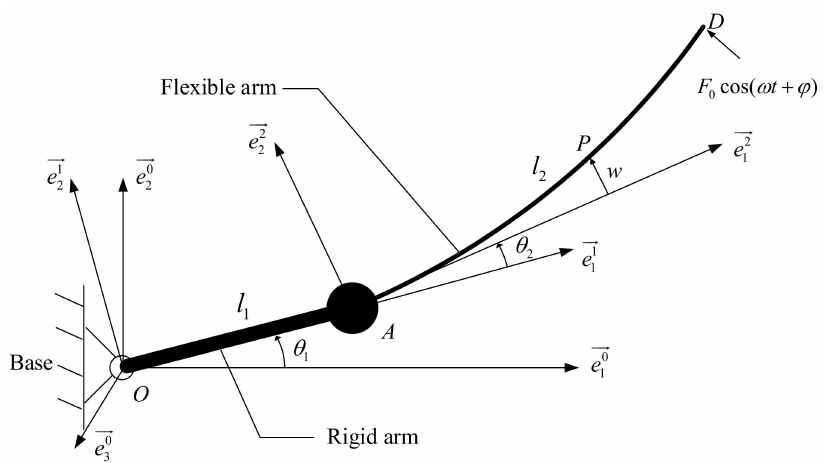
Figure 1. Simplified model of flexible